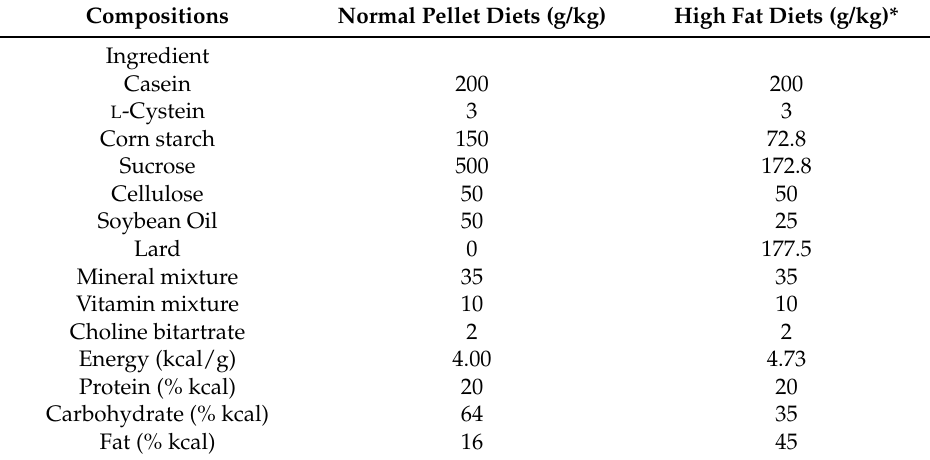
Table 1. Formulas for normal and high fat diets used in this study. Compositions Normal Pellet Diets (g/kg) High Fat Diets (g/kg)* Ingredient Casein 200 200 3 3 150 72.8 500